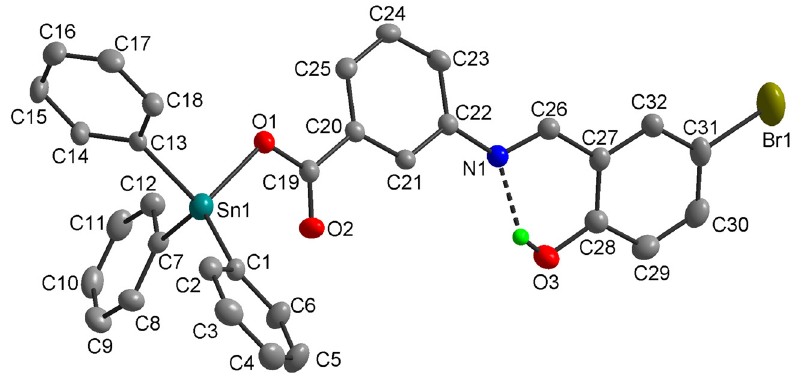
Figure 1: The molecular structure of 1. Ellipsoids are drawn at 30% probability level. Hydrogen atoms are omitted for clarity except H 3